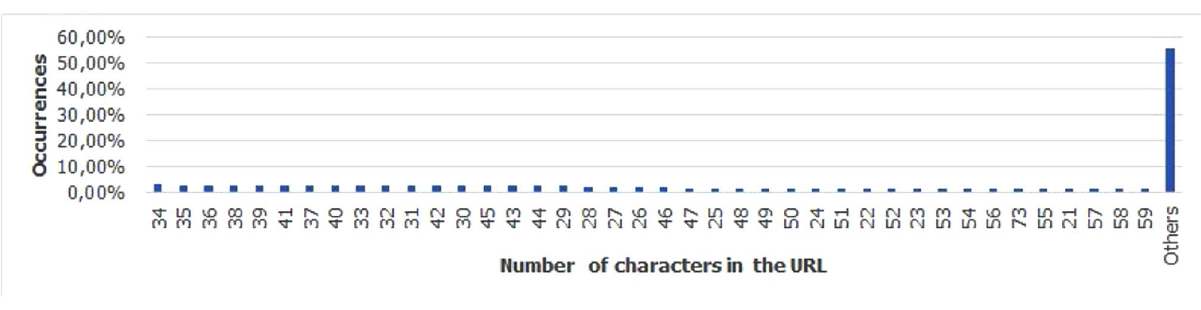
Figure 14. URL size occurences.